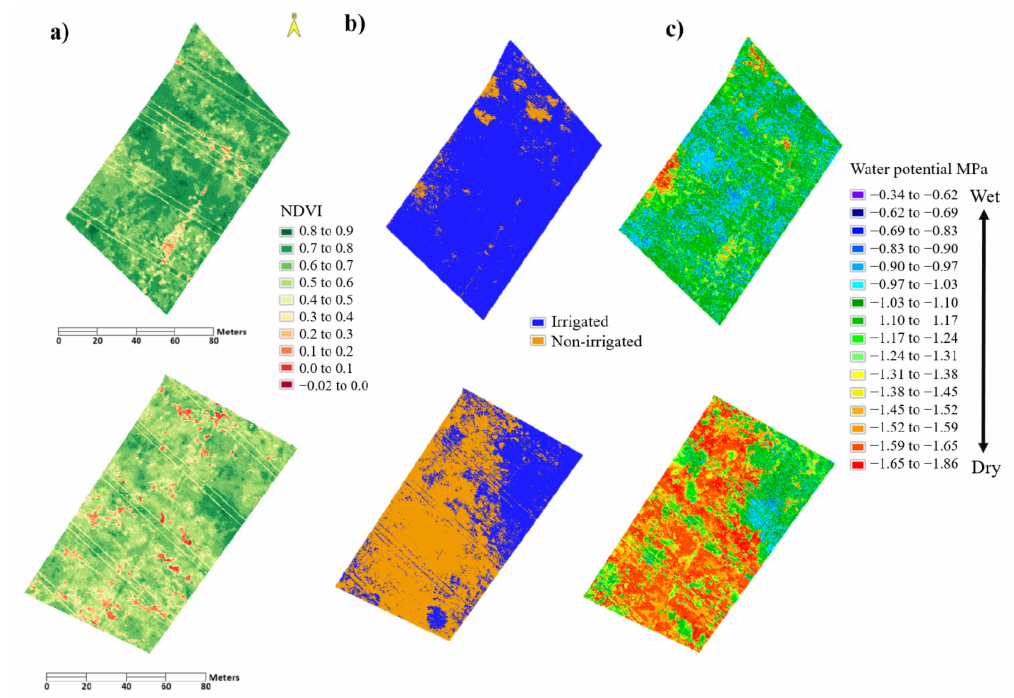
Figure 7. Processed scene images of irrigated (top images) and non-irrigated (bottom images) field sections over color break. ( a ) NDVI images of scenes. ( b ) Classified images of irrigated and non-irrigated scenes. ( c ) Predicted images of water